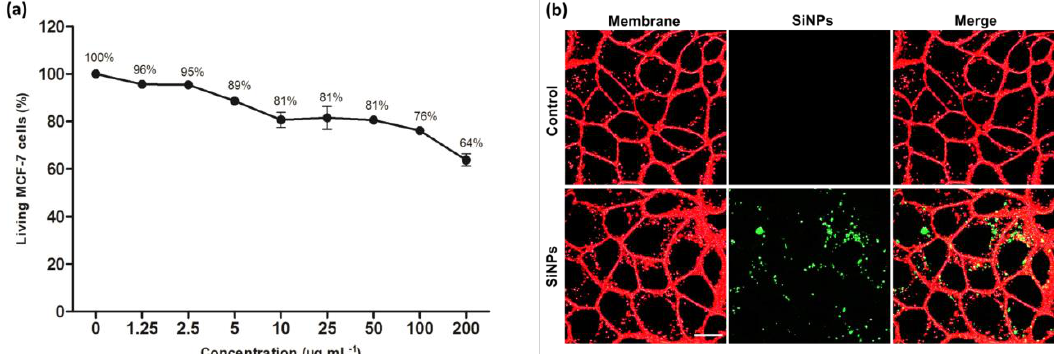
Figure 2. ( a ) Cell viability (%) of MCF-7 cells treated with increasing concentrations of SiNPs (from 1.25 to 200 µg mL −1 ) for 72 h. Data are presented as (mean ± SEM) of two independent experiments realized in triplicate; ( b ) Confocal microscopy imaging of living MCF-7 breast cancer cells after 24 h of incubation with or without (Control) 50 µg mL −1 of SiNPs and excited at 900 nm. Scale bar 5 µm.